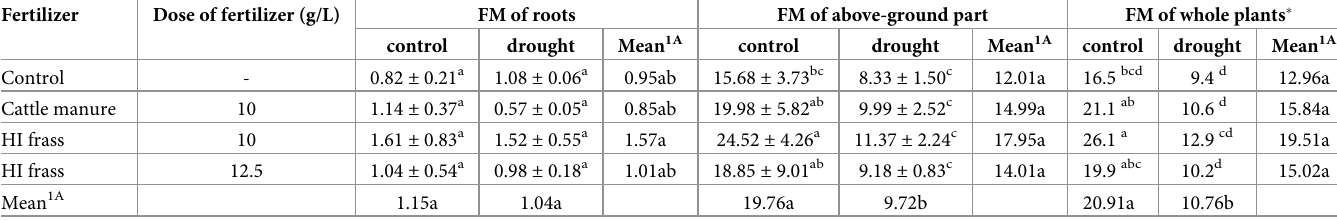
Table 2. Fresh mass (FM) of basil roots, above-ground part, and whole plants (g) under drought stress depending on the fertilizer used. Fertilizer Dose of fertilizer (g/L)